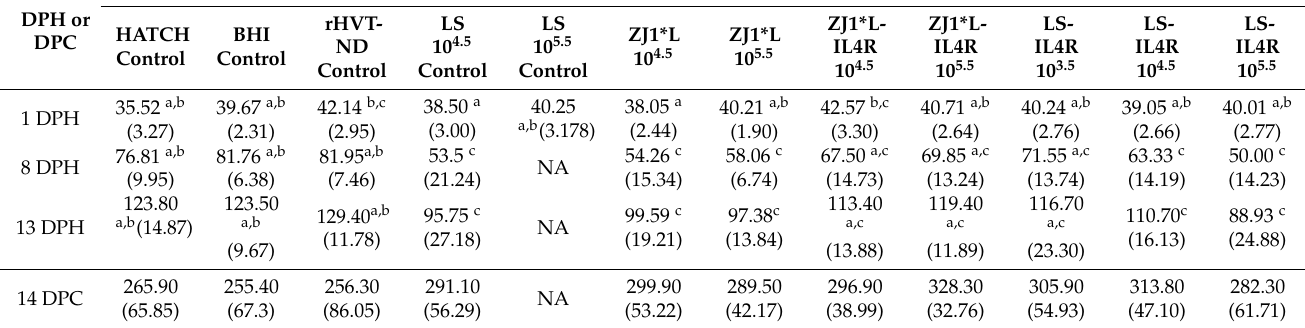
Table 1. Mean weights (and standard deviations) of chickens at 1, 8, and 13 days post-hatch after inoculation of commercial eggs at 18 days of embryonation with experimental in ovo vaccines and at 14 days post-challenge with virulent Newcastle disease virus.